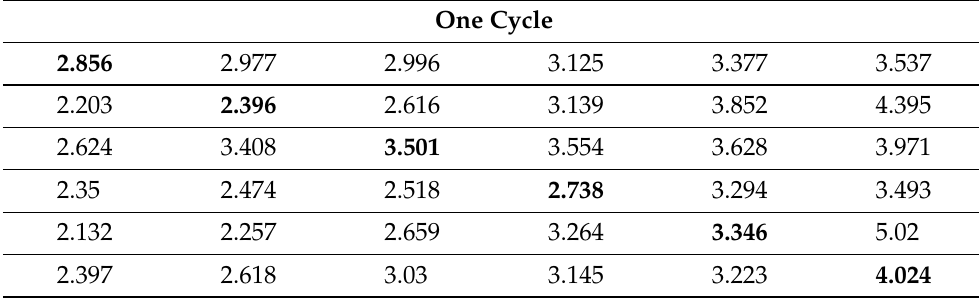
Table 12. RSS scheme from the GB( θ , λ ) distribution when c = 1 and n =